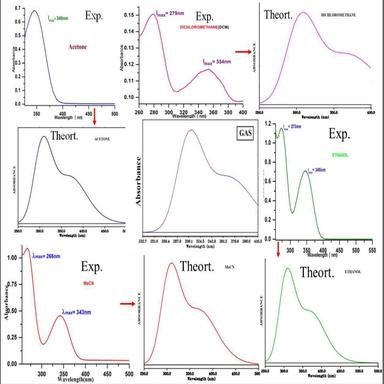
Experimental and theoretical UV-Vis spectra of H2L.